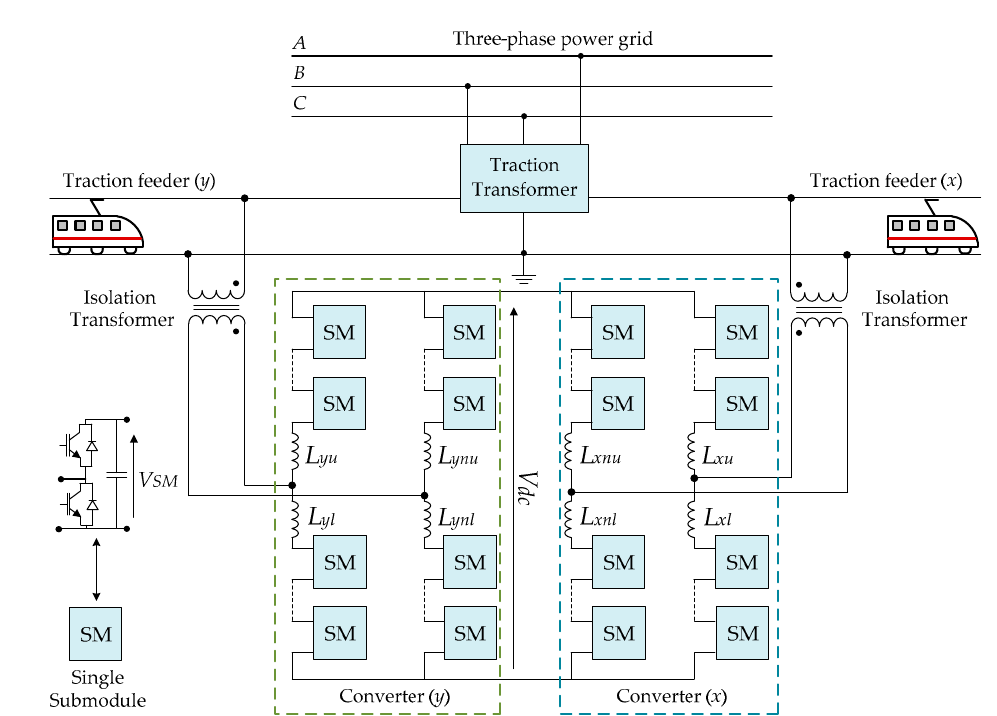
Table 10. Components quantities of the HB-MMC4 RPC.